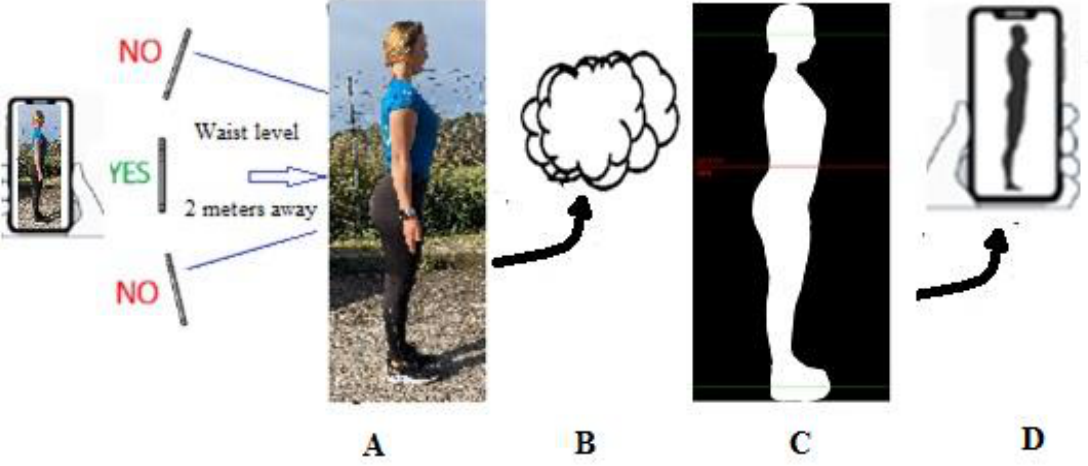
Figure 1. Illustration of the steps in the method of single-image, two-dimensional digital photography to characterize body shape and assess body composition: ( A ) image acquisition; ( B ) transfer to the Cloud for direct machine learning process including profile detection, extraction and conditioning of the image; ( C ) silhouette with body profile detect, extraction, conditioning; ( D ) return of silhouette with body shape and composition estimates.